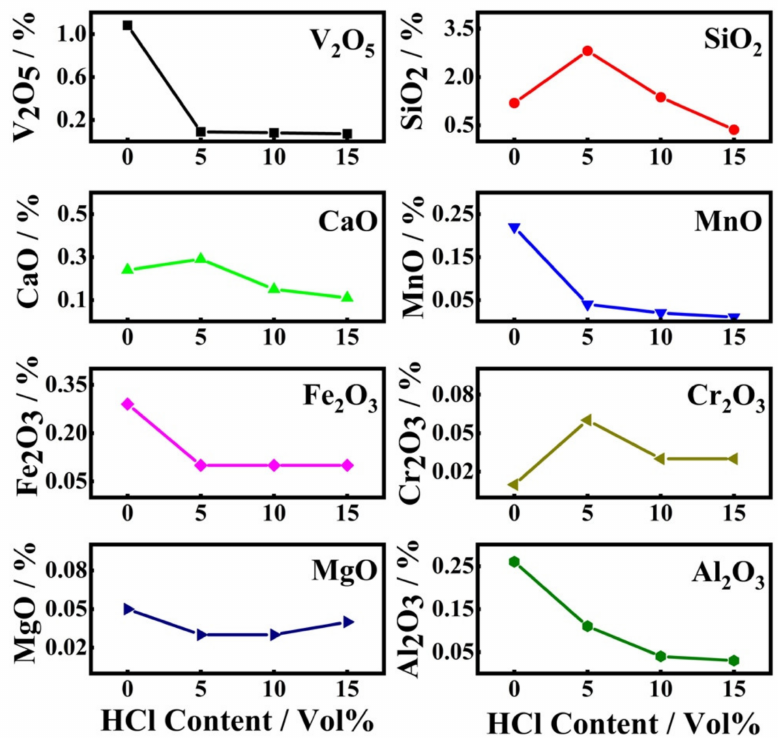
Figure 7. Effect of added HCl on the changing trend of impurities in TiO 2